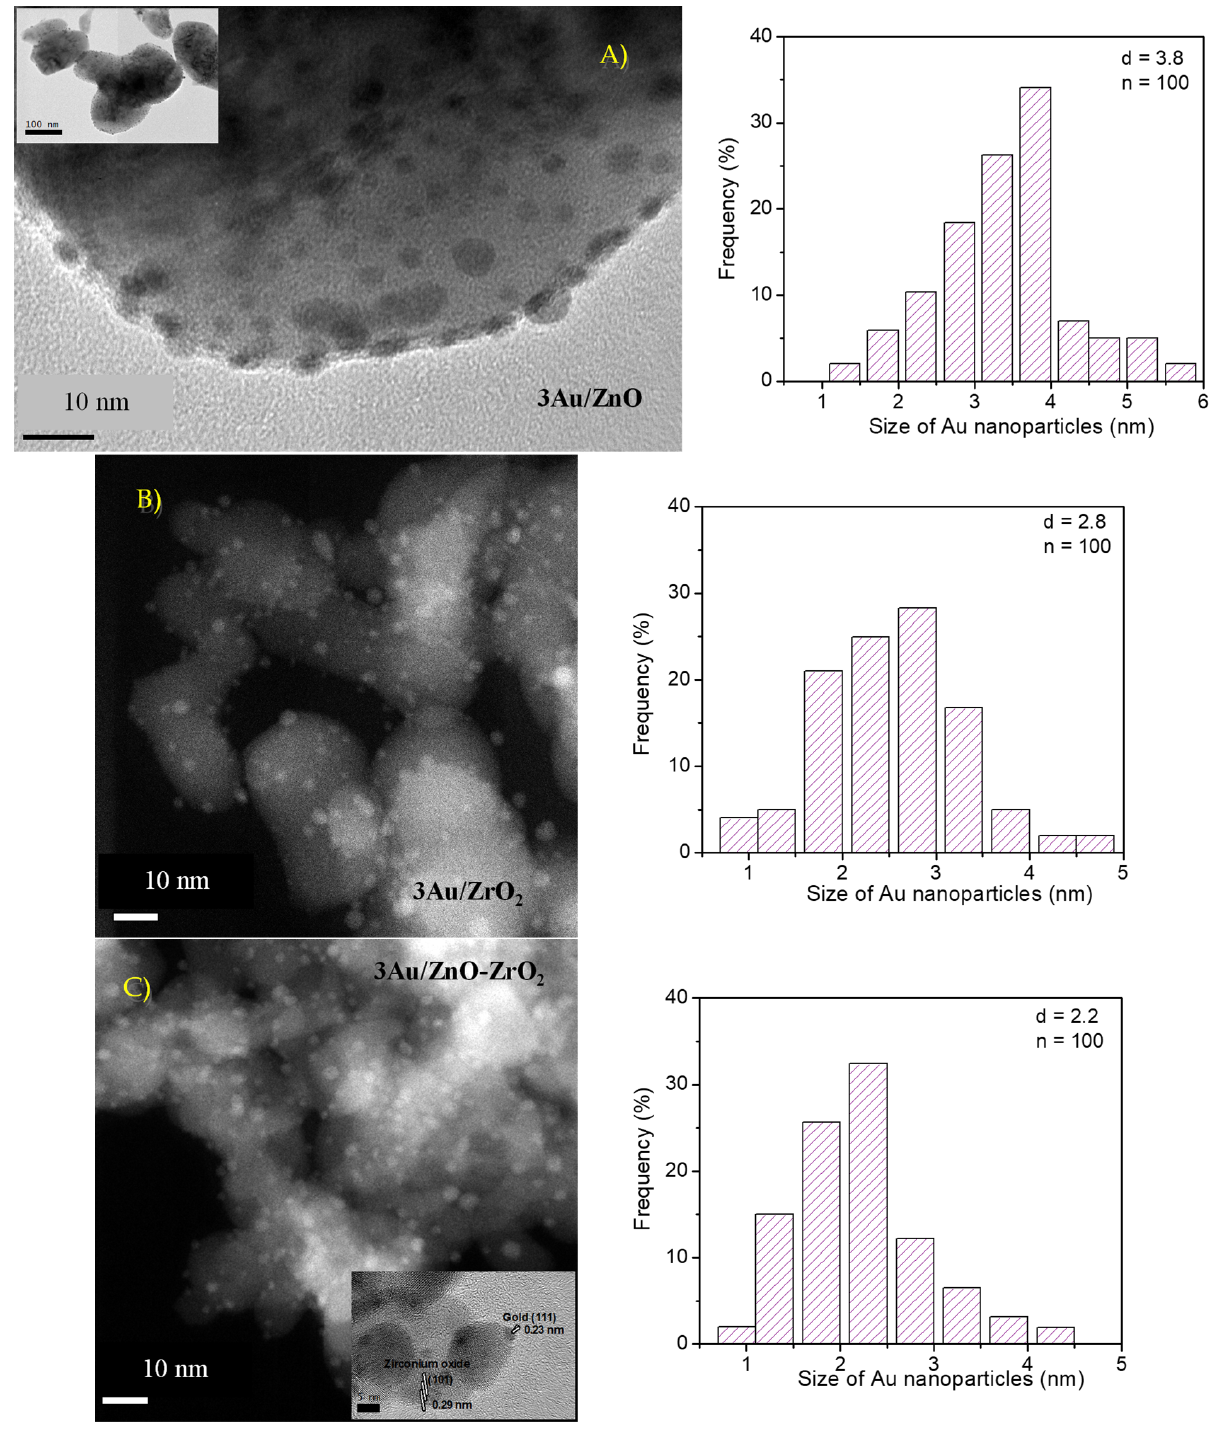
Figure 2. ( A ) HRTEM images of the 3Au/ZnO catalyst annealed at 200 °C in air and its corresponding crystal size frequency histogram, ( B ) HAADF/STEM images of the 3Au/ZrO 2 , and ( C ) 3Au/5ZnO − ZrO 2 catalysts and their corresponding particle size frequency histograms.